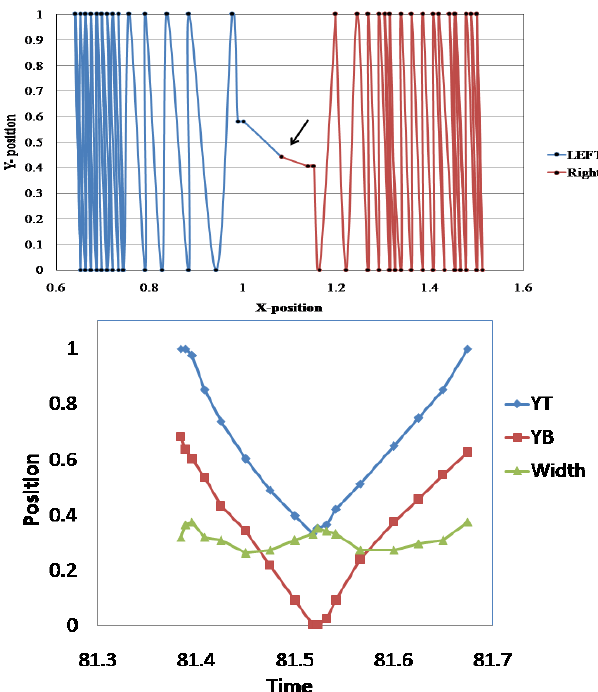
Electric field Eo=1.1 kV/cm for drop radius 0.875 mm.